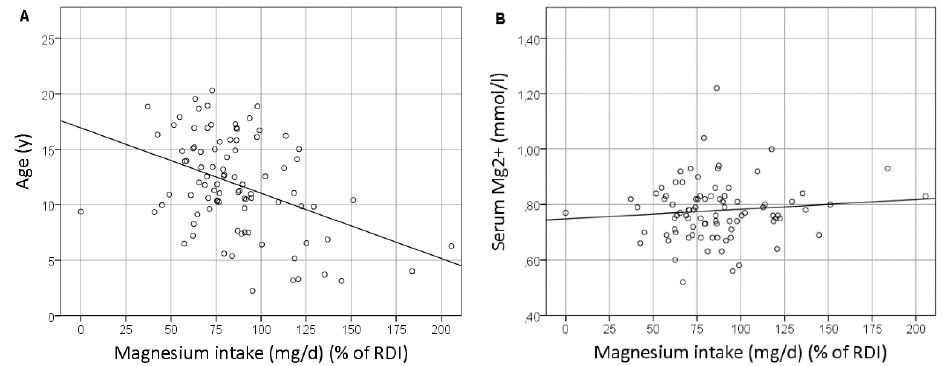
Figure 1. Correlation between the magnesium intake and age ( A ) and the serum magnesium level ( B ). RDI: Recommended daily intake.